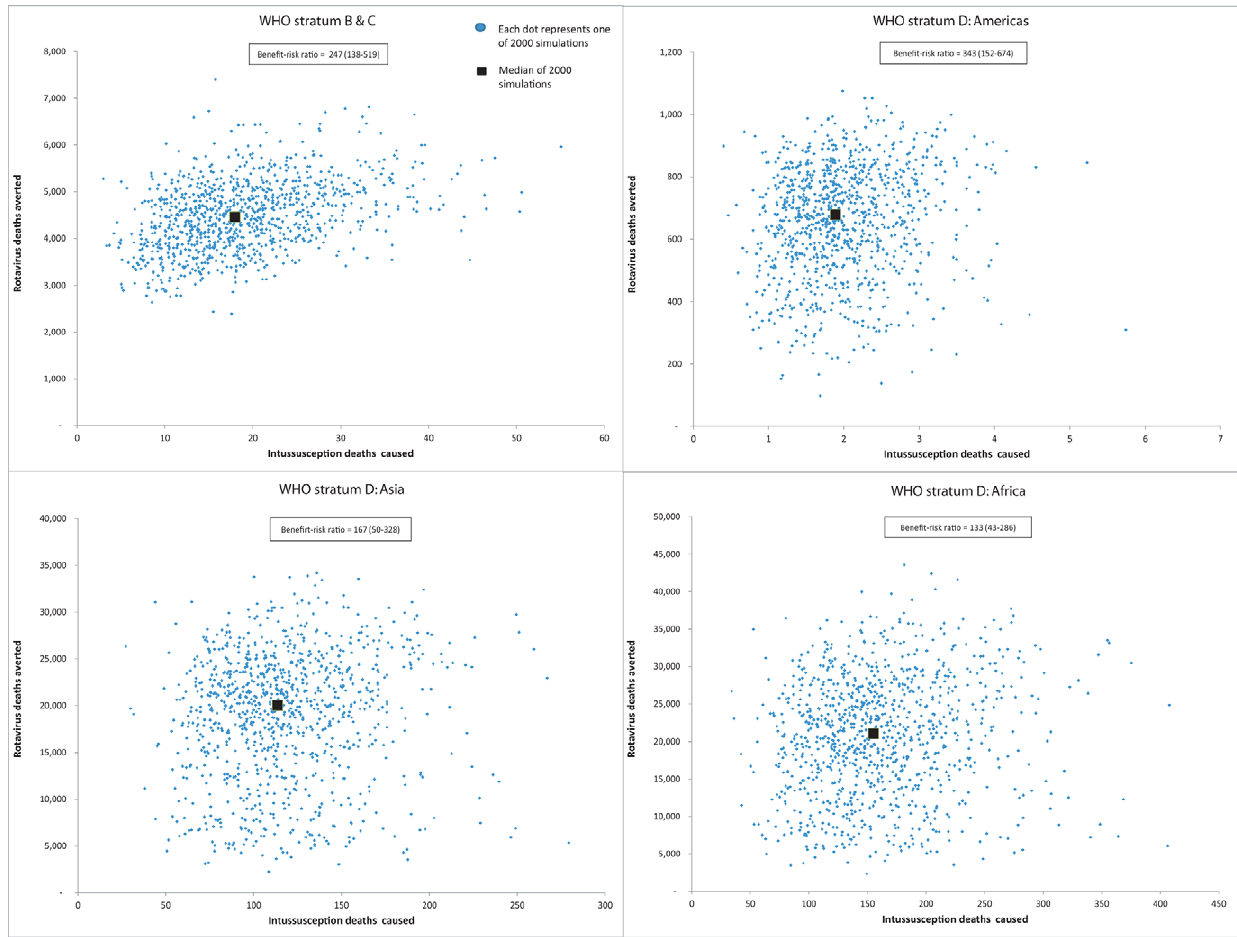
Figure 4. WHO region specific analysis of relationship between esimated number of rotavirus gastroenteritis deaths avoided versus intussusception deaths caused by removal of the age restrictions for rotavirus vaccination. These estimates are from 2,000 simulations with each blue dot representing a potential estimate of rotavirus deaths prevented (y-axis) versus intussusception deaths caused (x-axis) from removal of the age restrictions given the uncertainty on the parameters in the model: rotavirus mortality, vaccine efficacy, vaccine coverage, intussusception incidence, intussusception risk from vaccine, and intussusception fatality. The black square represents the median estimate. Because group A countries with very low child mortality (i.e., high-income) represent , 0.1% of the global rotavirus deaths, they were excluded from this analysis.